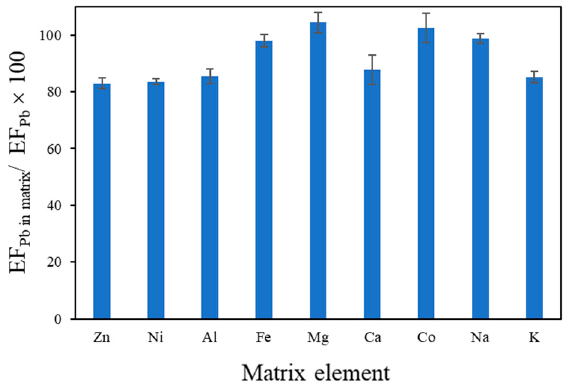
Figure 7. Interference by coexisting elements on the preconcentration of Pb with aminosilanized Fe 3 O 4 . Sample: Pb 0.3 ng · mL − 1 , 100 mL; matrix element; 1000 ng · mL − 1 for all elements; pH: 5; sorption time (magnetic stirring time): 5 min; ultrasonic desorption agent: 1 mL of 0.3 mol · L − 1 HNO 3 .